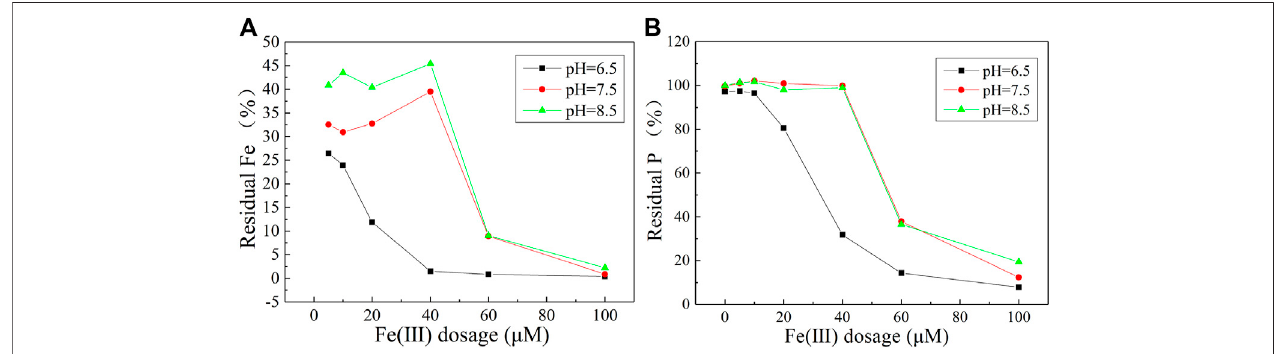
FIGURE 1 | Residual percentage of Fe(III) (A) and PO 43 − (B) at the end of precipitation reaction in the absence of WSOM.